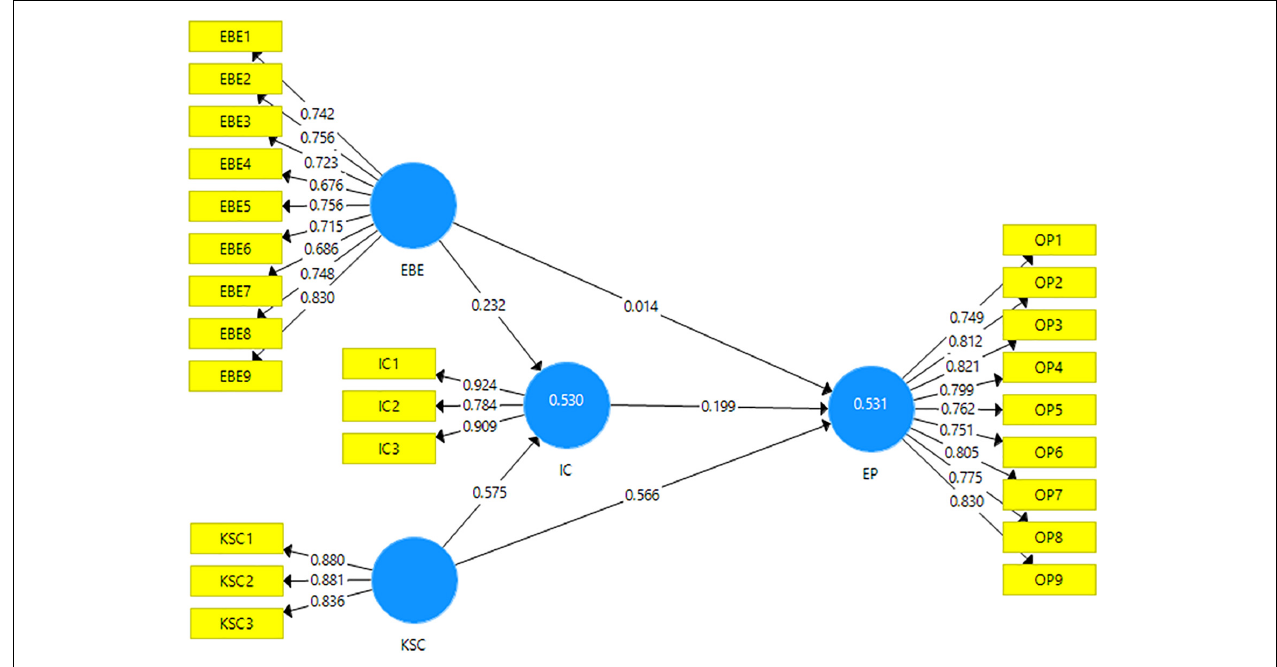
FIGURE 2 | Measurement model. EBE, employee brand equity, KSC, knowledge sharing culture, IC, innovative capabilities, EP, enterprise performance.